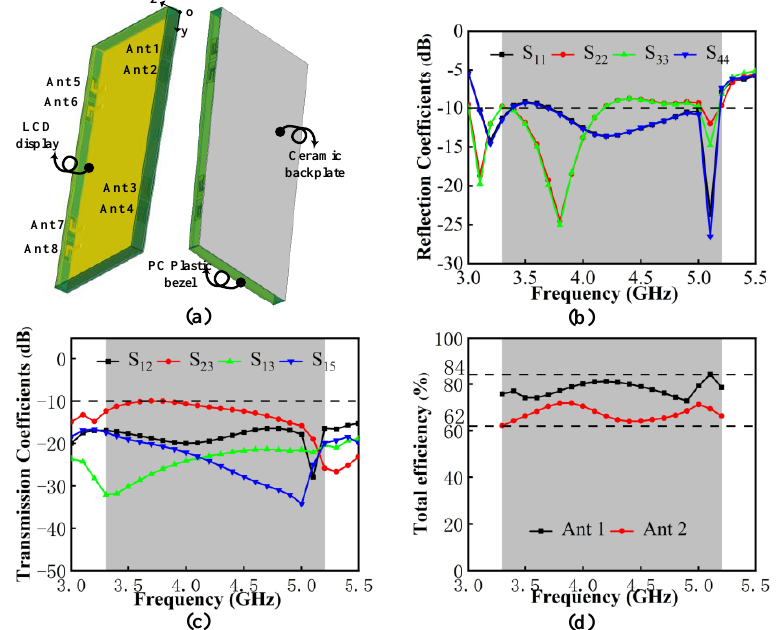
Figure 25. ( a ) MIMO system with mobile phone model. ( b ) Simulated reflection coefficients. ( c ) Simulated transmission coefficients. ( d ) Simulated total efficiency.